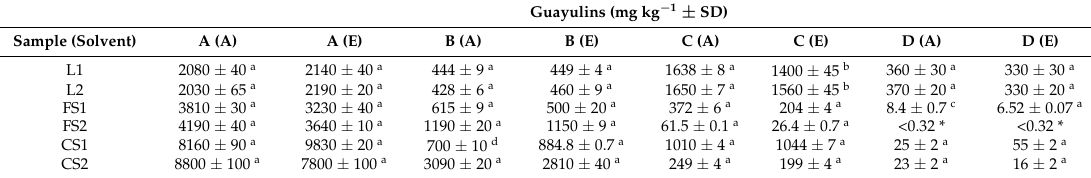
Table 4. Concentration of guayulins A, B, C and D in acetone or ethanol extracts of Guayule biomass (leaves (L), fine stems (FS) and coarse stems (CS)) harvested in January 2015 (dried samples, 1) and in September 2015 (fresh samples,